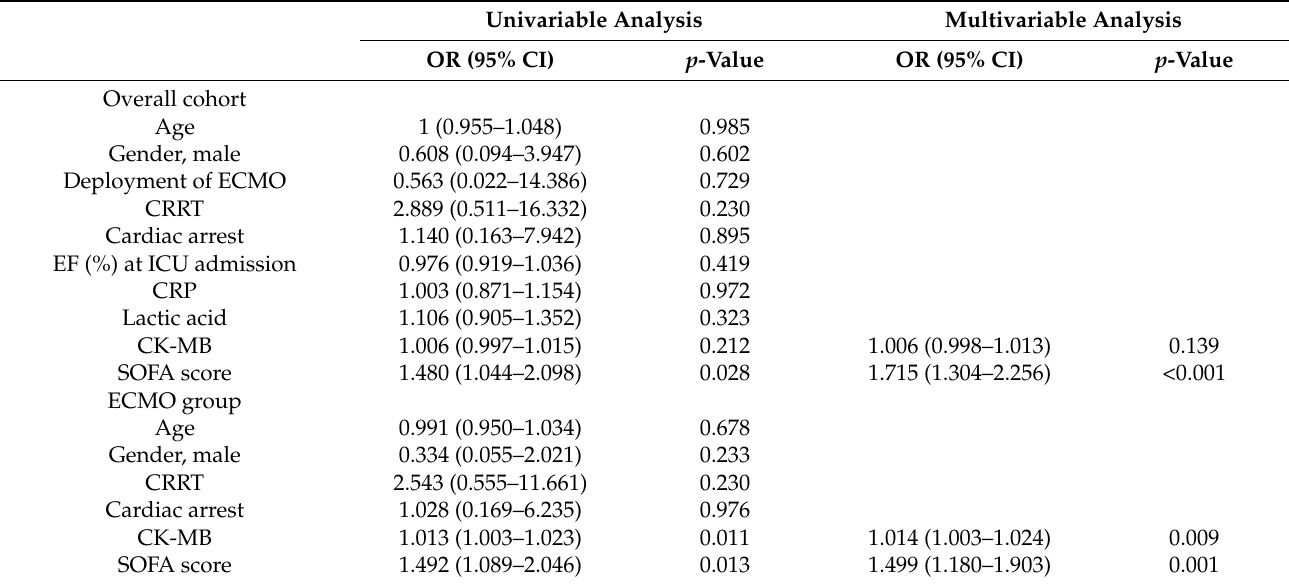
Table 3. Multivariable analysis of in-hospital